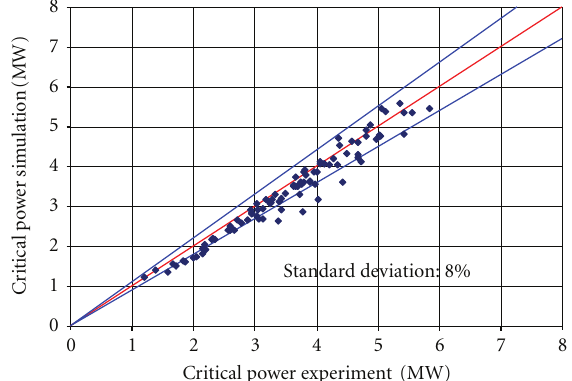
Figure 21: Measured and simulated critical power values for assem- bly A8.